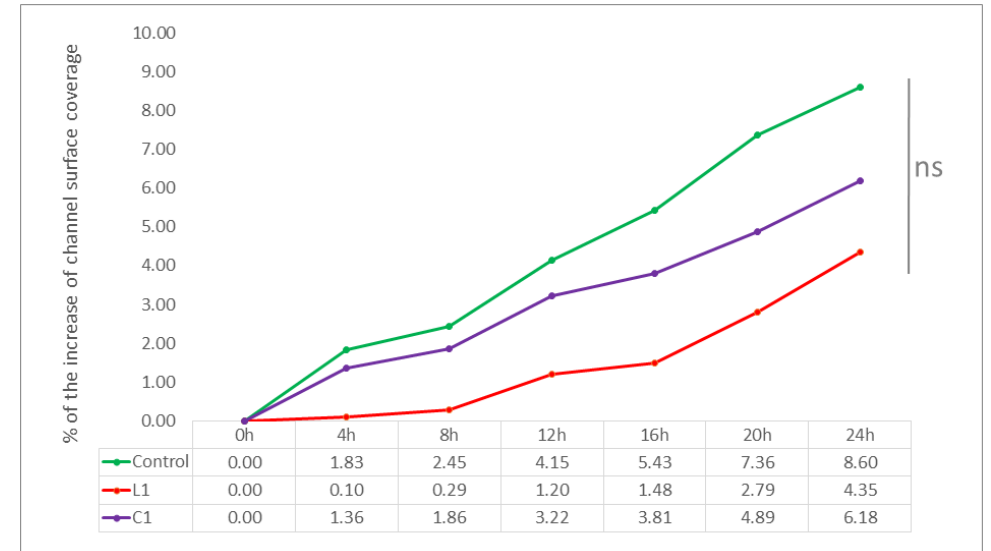
Figure 6. Growth dynamics of biofilm biomass of C. albicans CA2 over 24 h in the presence of lipopeptides L1 and C1, expressed as a percentage of channel coverage in the BioFlux Z1000 system. For all tested samples, the biofilm obtained after 24 h of growth in the absence of any substances (a biofilm development phase) was taken as the starting point. All experiments were repeated in triplicate. NS — non-significant.